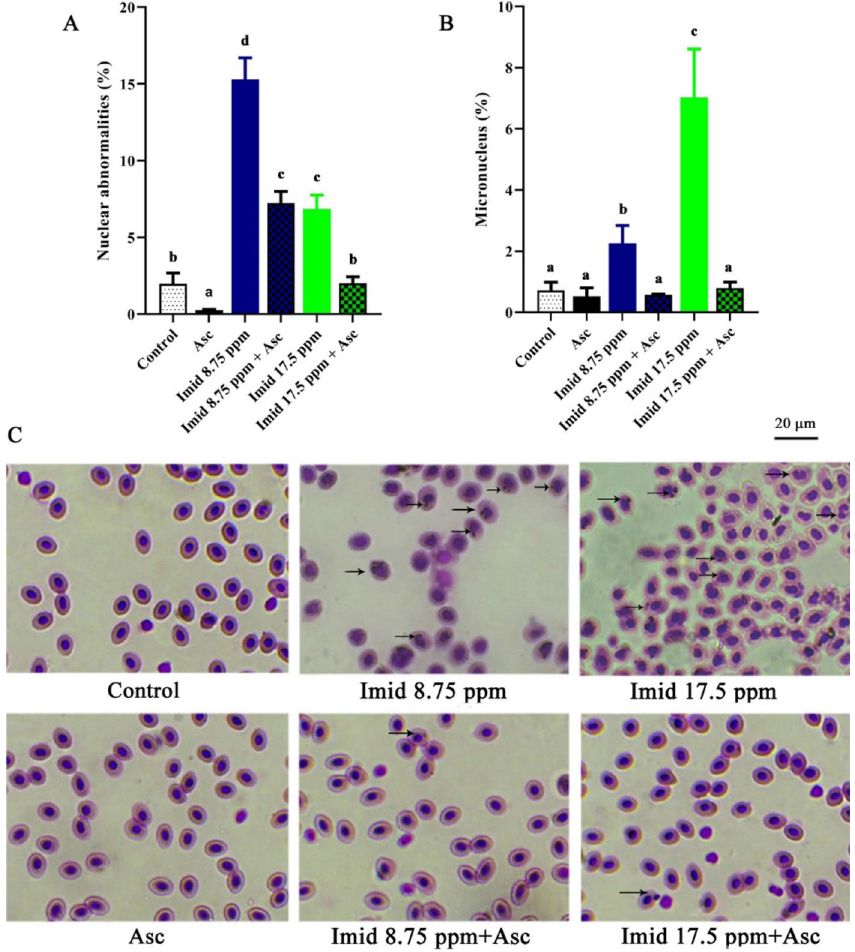
Figure 5. Representative micro-photographs of micronuclei (MN) and erythrocytic nuclear abnormalities (ENA) in O. niloticus , stained with hematoxylin and eosin. The protective effect of ascorbic acid (Asc, 50 ppm) against the alterations induced by imidacloprid (Imid) concentrations (8.75 and 17.5 ppm) for 21 days. Black arrows refer to the abnormal nuclear morphology. Values were expressed as mean ± standard deviation (SD), bars refer to SD, (n = 5 fish). Different letters above the columns indicate significant differences at p < 0.05 between